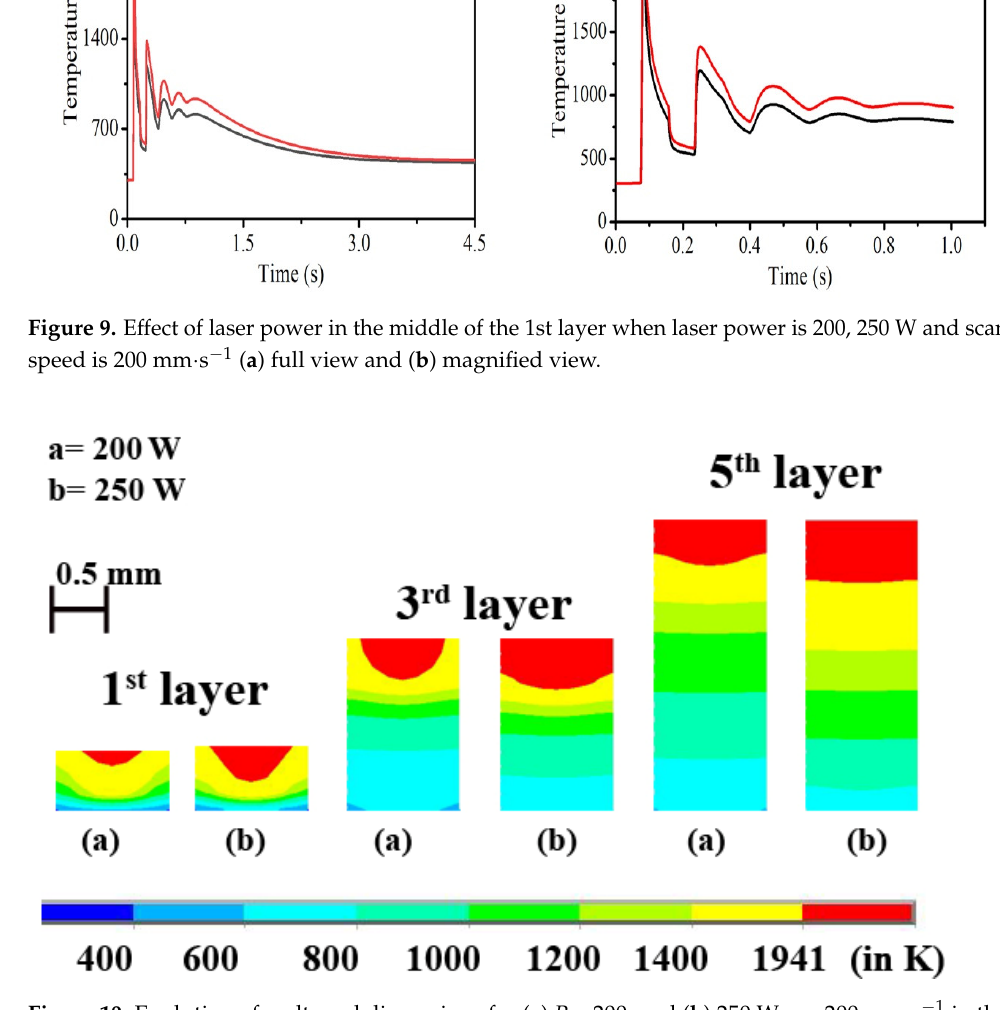
Figure 10. Evolution of melt pool dimensions for ( a ) P = 200, and ( b ) 250 W, v = 200 mm·s − 1 in the 1st, 3rd and 5th layer.